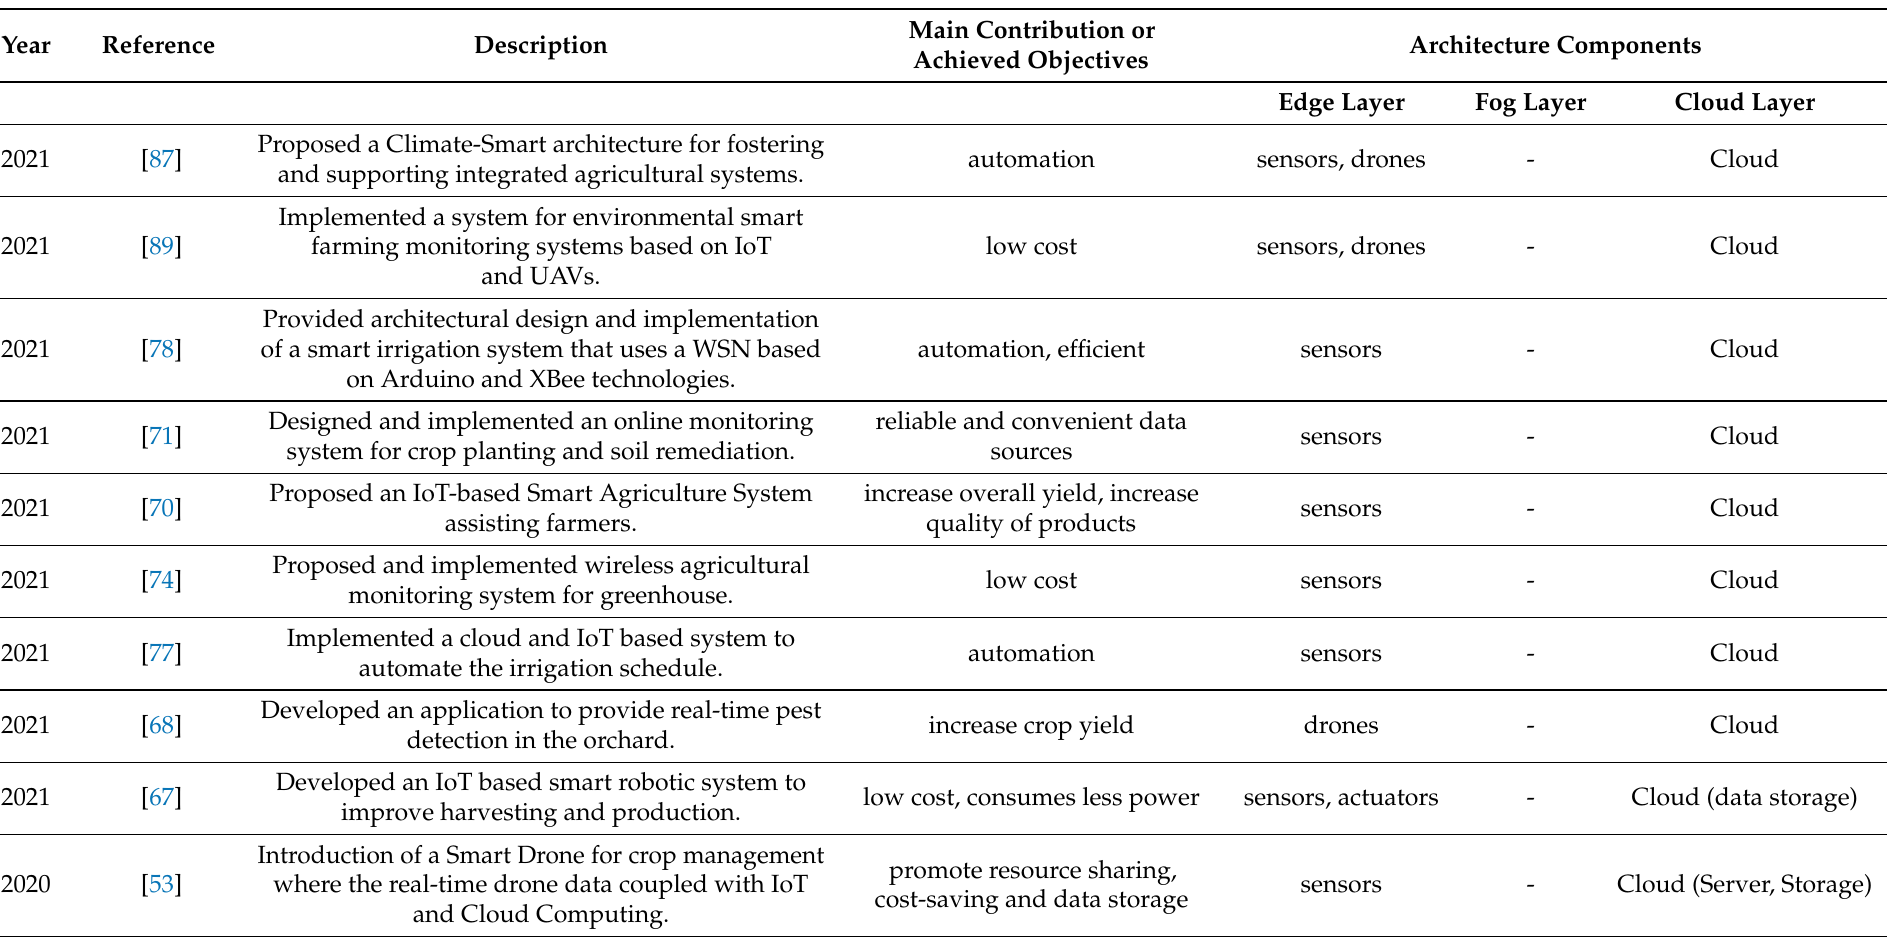
Table 6. Existing